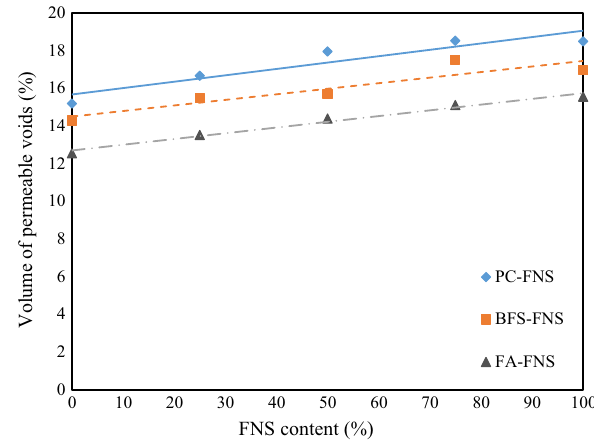
Fig. 5 Relationship between volume of permeable voids and FNS